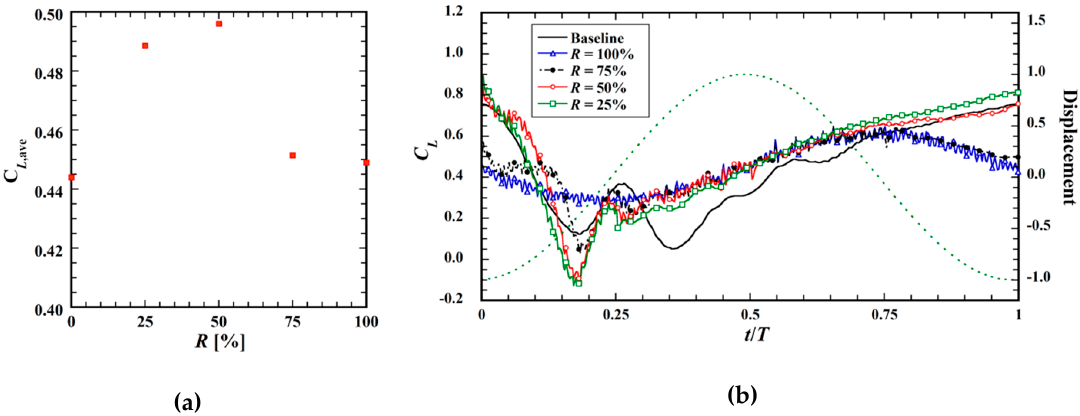
Figure 17. Effects of the driving ratio on the lift coefficient ( t 0 / T = 0) for the control only on the top surface. ( a ) Time-averaged lift coefficient; ( b ) Time fluctuations of lift